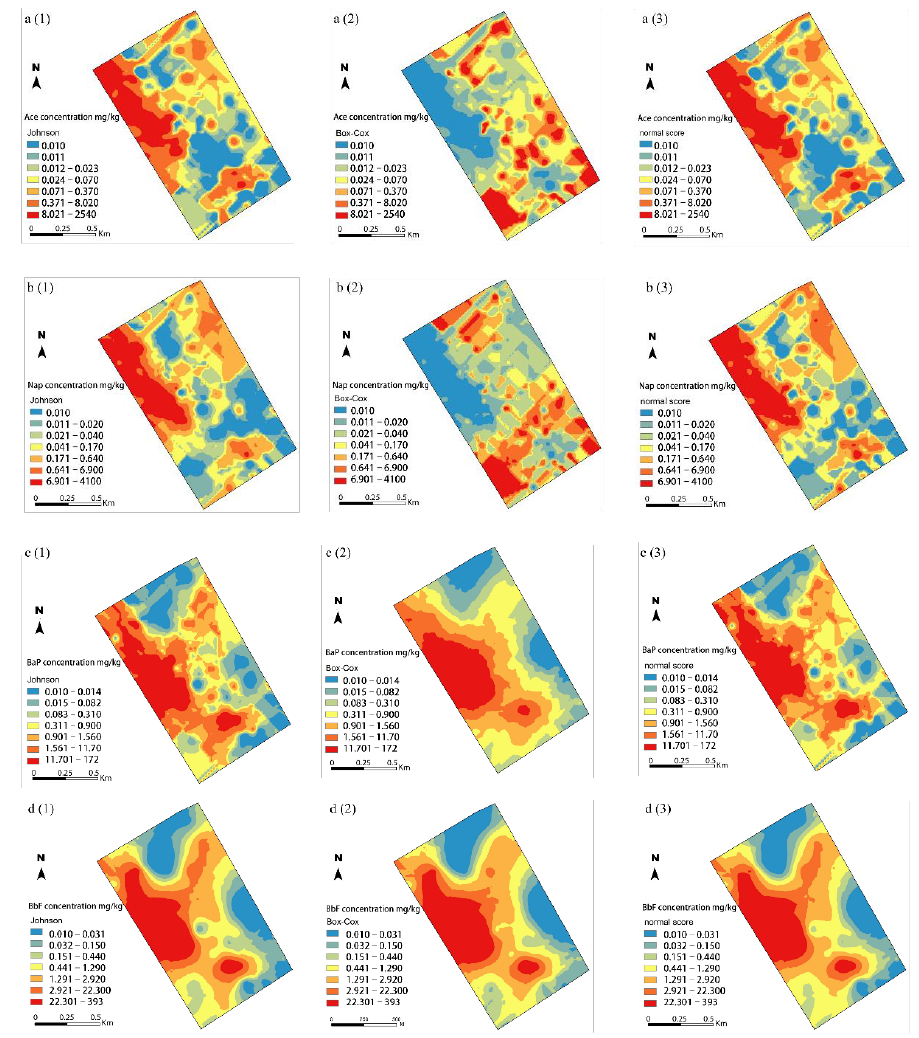
Figure 4. Spatial interpolation of transformed soil Ace ( a1 – a3 ), Nap ( b1 – b3 ), BaP ( c1 – c3 ), and BbF ( d1 – d3 ) concentrations: (1) Johnson transformed data; (2) Box-Cox transformed data; (3) normal score transformed data.